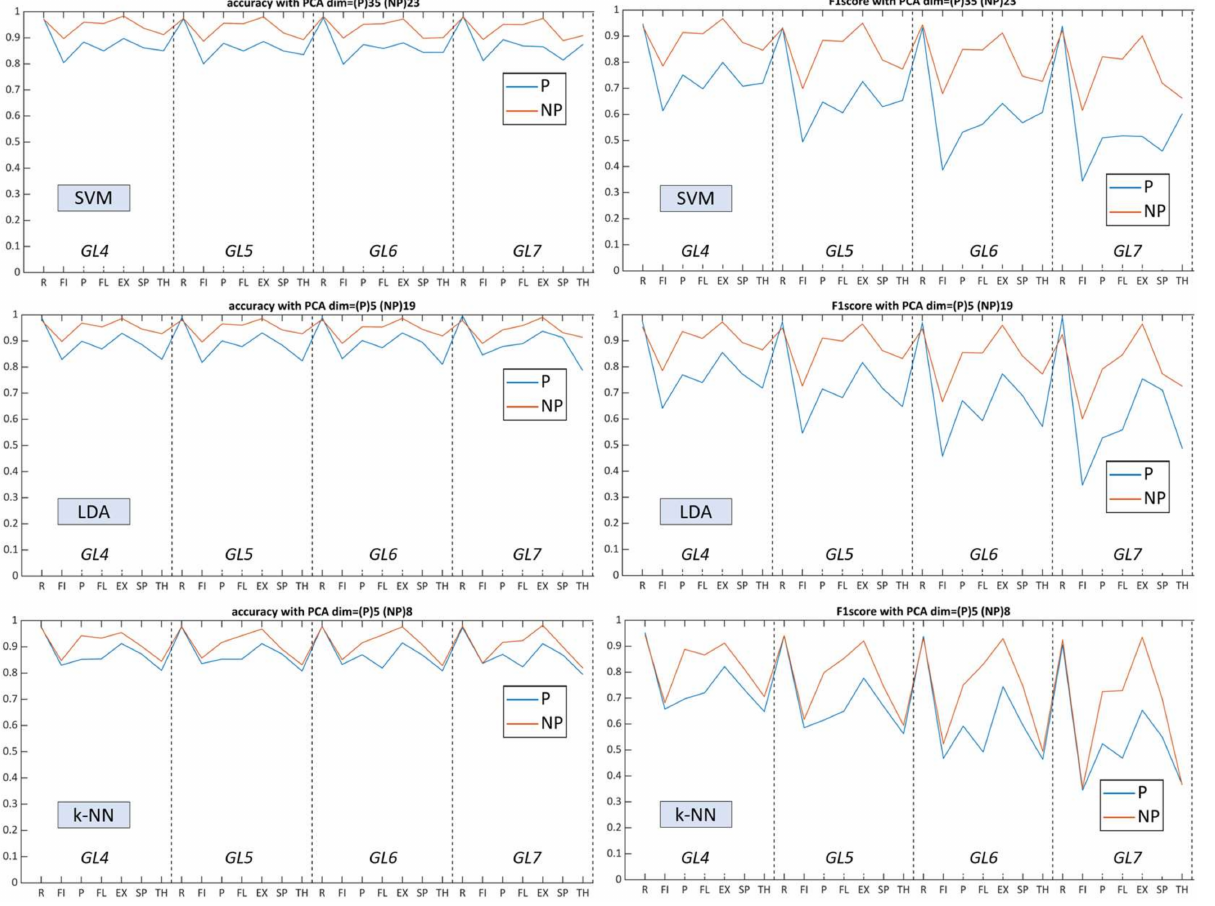
Figure 9. Total accuracy rate and F 1 -score from GLs models on NP19 and P19 with best PCA settings: top figures show mean Acc and F 1 from SVM, middle figures show mean Acc and F 1 from LDA, and bottom figures show mean Acc and F 1 from